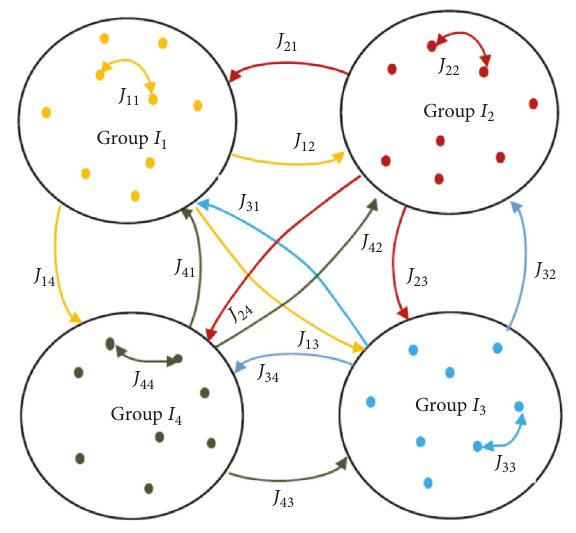
Figure 1: A representation of the interaction network for our model. Population is divided into four groups 𝐼 1 , 𝐼 2 , 𝐼 3 , and 𝐼 4 . Within 𝐼 1 (resp., 𝐼 2 , 𝐼 3 , and 𝐼 4 ) individuals feel a mean-field interaction with coupling 𝐽 11 (resp., 𝐽 22 , 𝐽 33 , and 𝐽 44 ). Besides, group 𝐼 1 influences the other groups through strength 𝐽 12 , 𝐽 13 , 𝐽 14